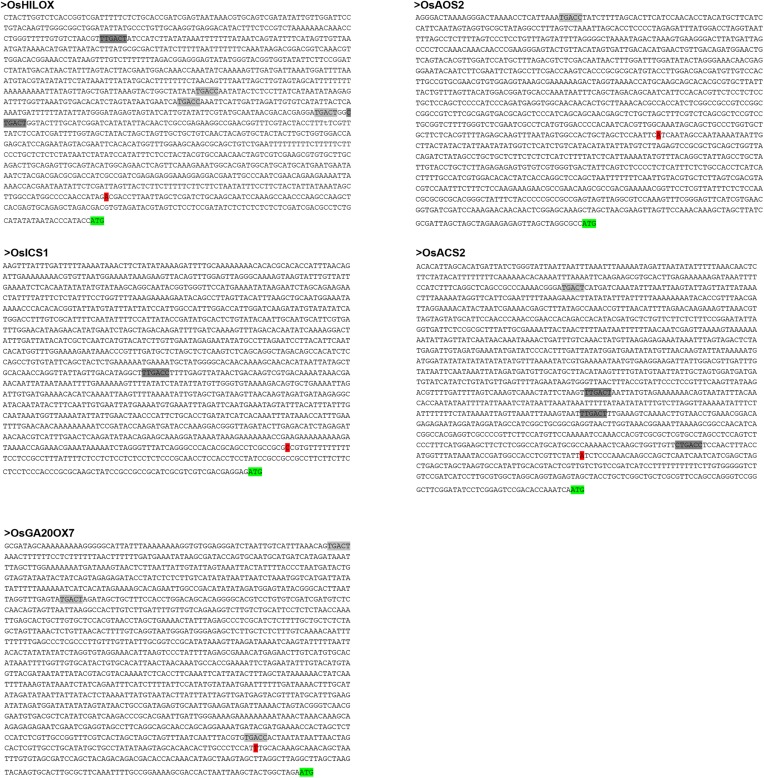
W-box elements in promoter regions of OsHI-LOX, OsICS1, OsAOS2, OsACS2, and OsGA20ox7.Green highlights represent the translation initiation sites. Red highlights represent the transcription start sites that were predicted by BDGP (http://www.fruitfly.org/seq_tools/promoter.html). Dark gray highlights and gray highlights represent W-box (C/TTGACT/C) and W-box like (TGACT/C) motif, respectively, which were predicted by PLACE (http://www.dna.affrc.go.jp/htdocs/PLACE/).